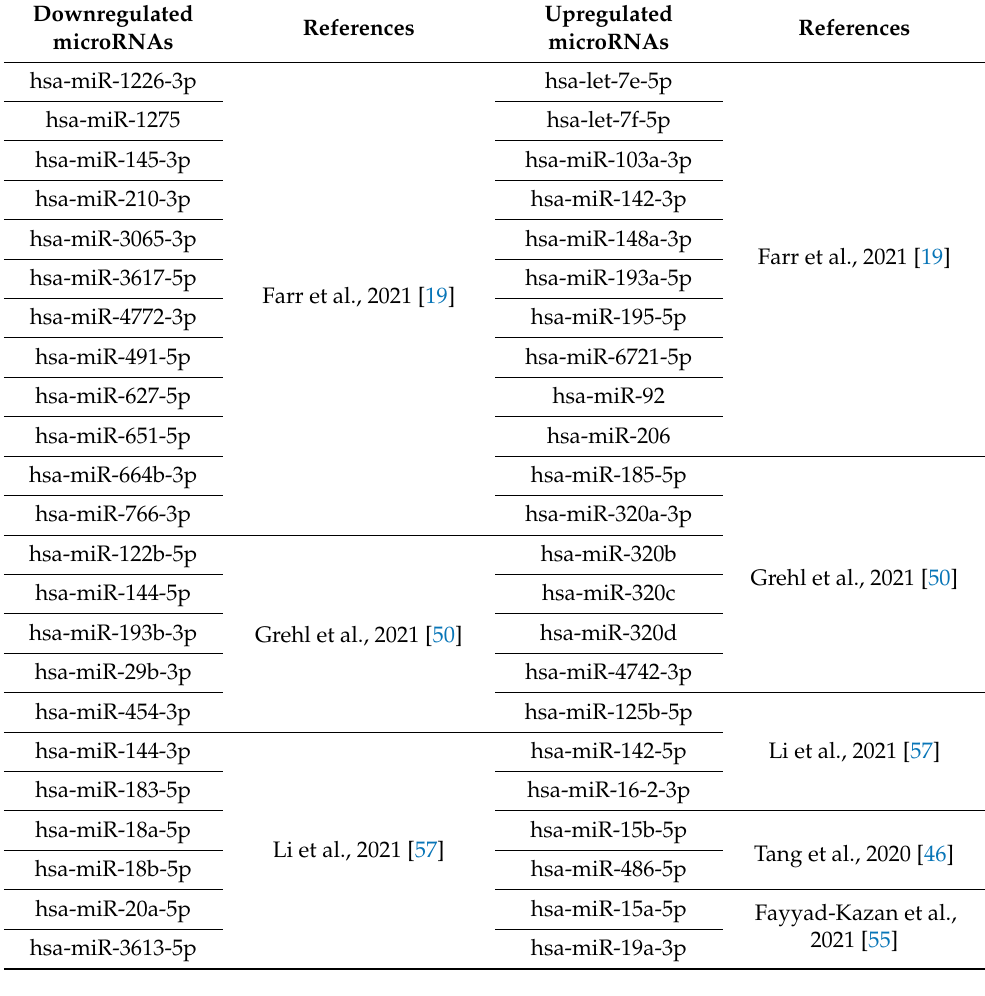
Table 1. List of miRNAs in silico predicted and experimentally validated. Downregulated microRNAs